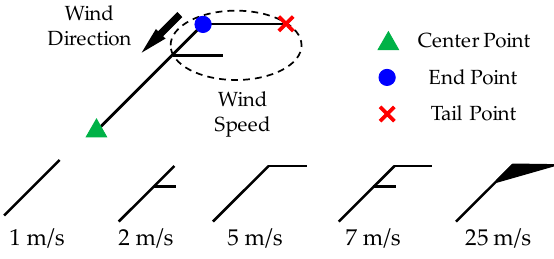
Figure 4. A standard station model for wind direction and speed with the location of each point.